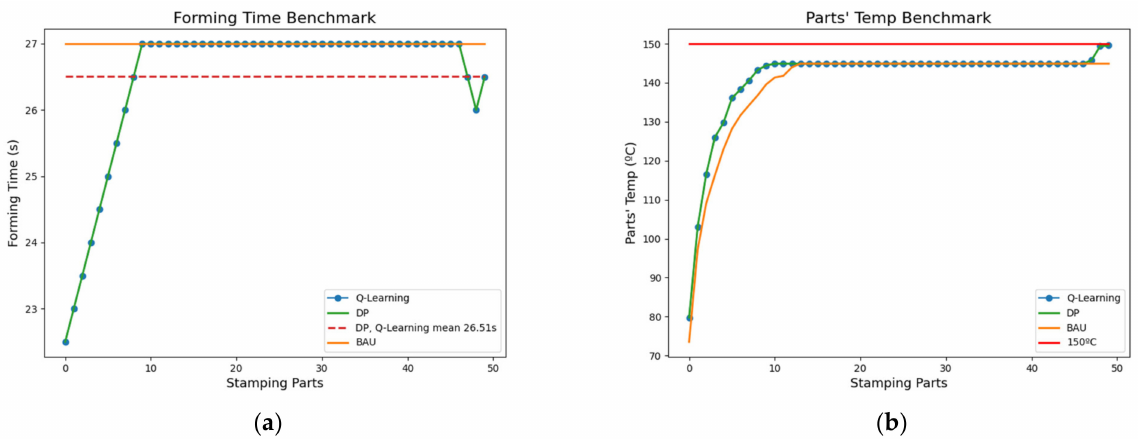
Figure 9. Best BAU, DP, and Q-Learning solutions benchmark for a batch execution; ( a ) Forming time setting benchmark, ( b ) Final parts temperature